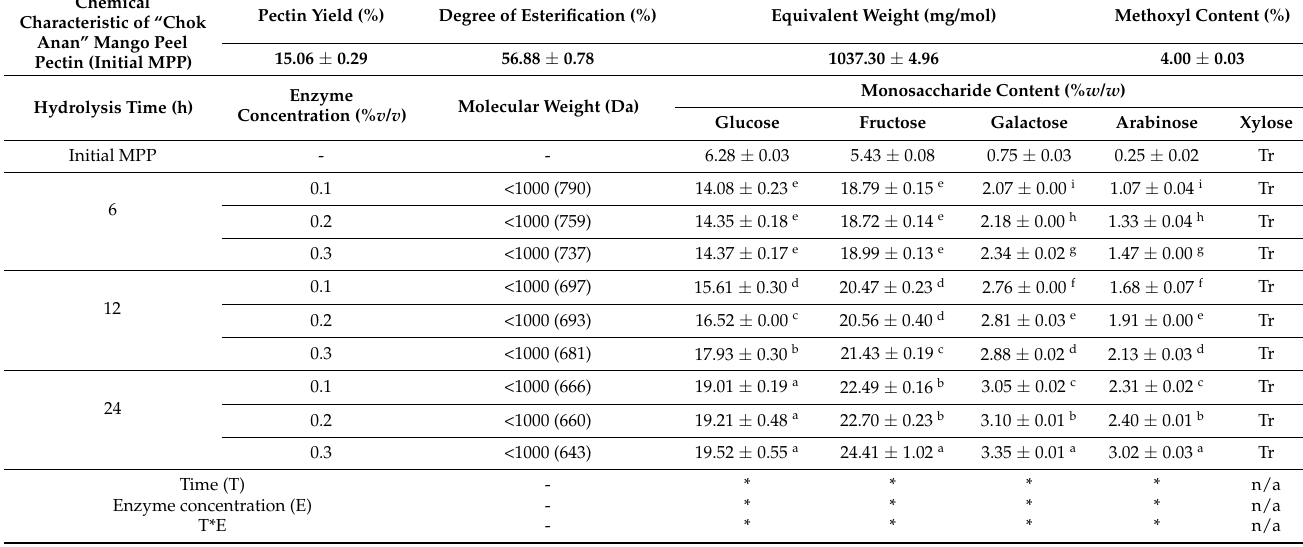
The result of the molecular weight detected <1000 Da in all samples using ultrahydrogel linear 1 column. Numbers in the brackets are the M z values reported from the built-in software. Average ± standard deviation with different subscription letters in each row (treatment) is significantly different ( p < 0.05). Subscription (*) indicates significantly difference ( p < 0.05) using two-way ANOVA with Duncan’s multiple range test. Monosaccharide concentrations were expressed as g/100 g dry weight. Tr = trace amount (<0.01% w/w ). n/a = not